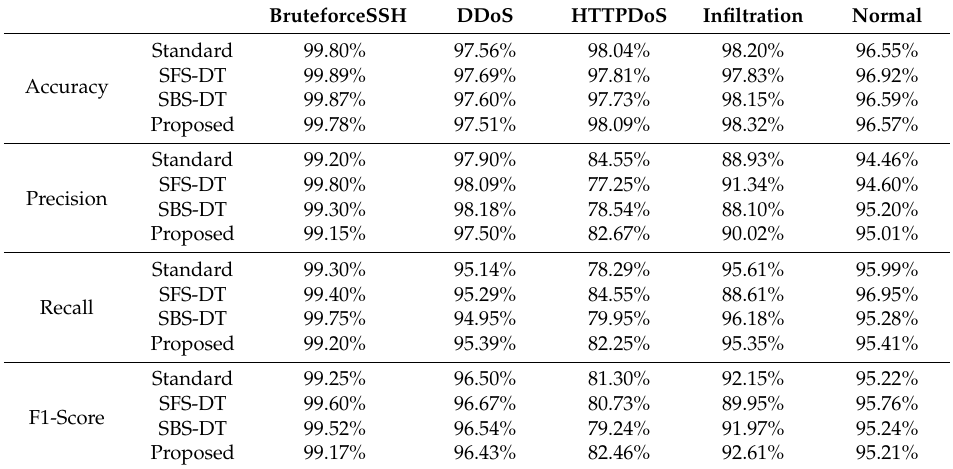
Table 8. Class detection based on each feature selection method for the ISCX-IDS 2012